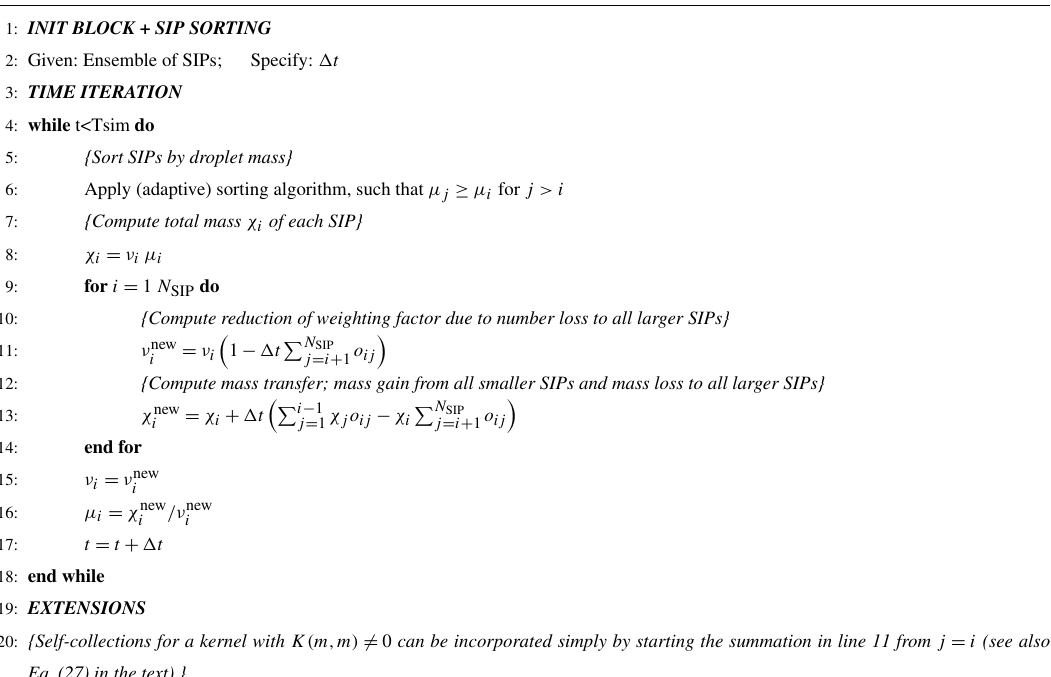
Algorithm 2 Pseudo-code of the average impact algorithm (AIM); style conventions are explained at the end of Sect.